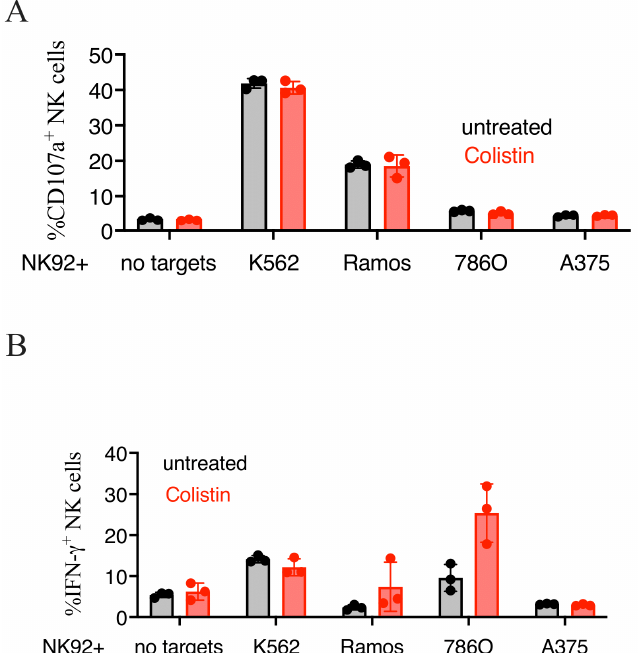
Figure 7. Treatment with Colistin sulfate increased IFN- γ production of NK92 stimulated with 786O cells. NK92 cells were stimulated at a 1:1 ratio with K562, Ramos, 786O, or A375 cells in the presence or absence of 10 µ M of colistin for 5-h at 37 ◦ C. After incubation, NK cells were stained for CD107a externalization ( A ) and IFN- γ production ( B ). Technical replicates of one experiment, representative of three performed, are shown.